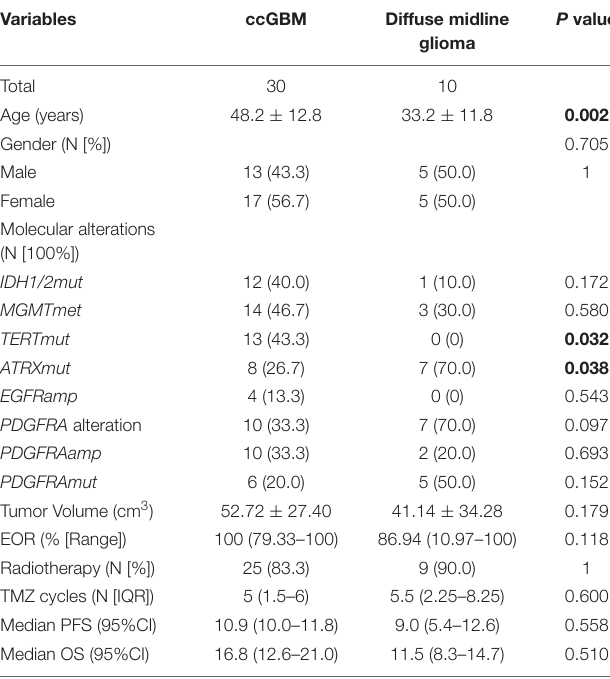
TABLE 7 | Comparison of molecular alterations and survival between ccGBM and diffuse midline glioma.